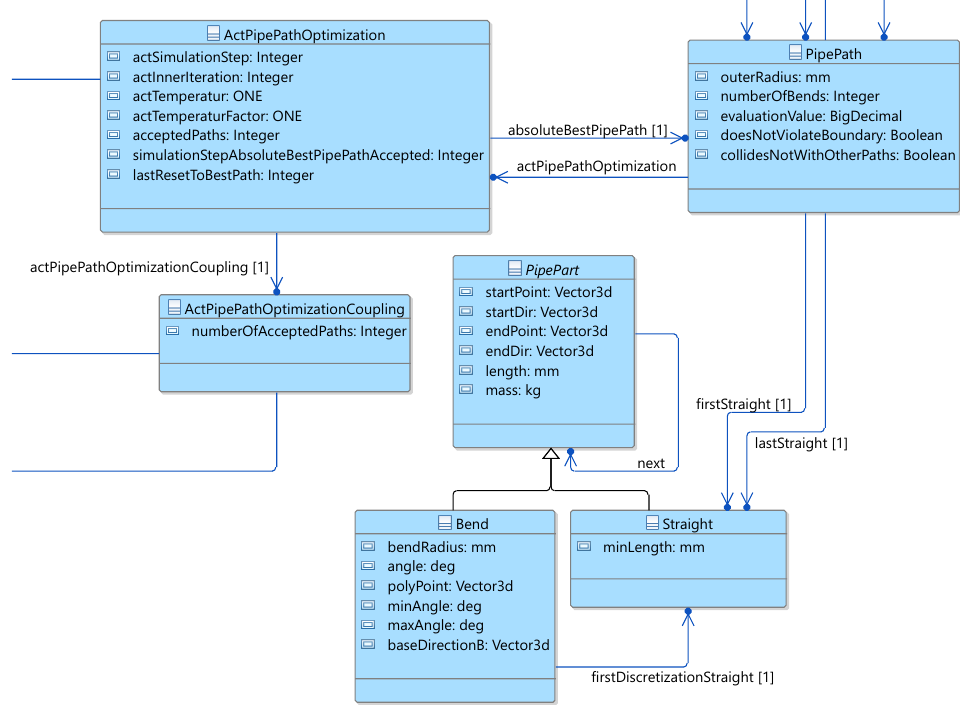
Figure 9. Class diagram